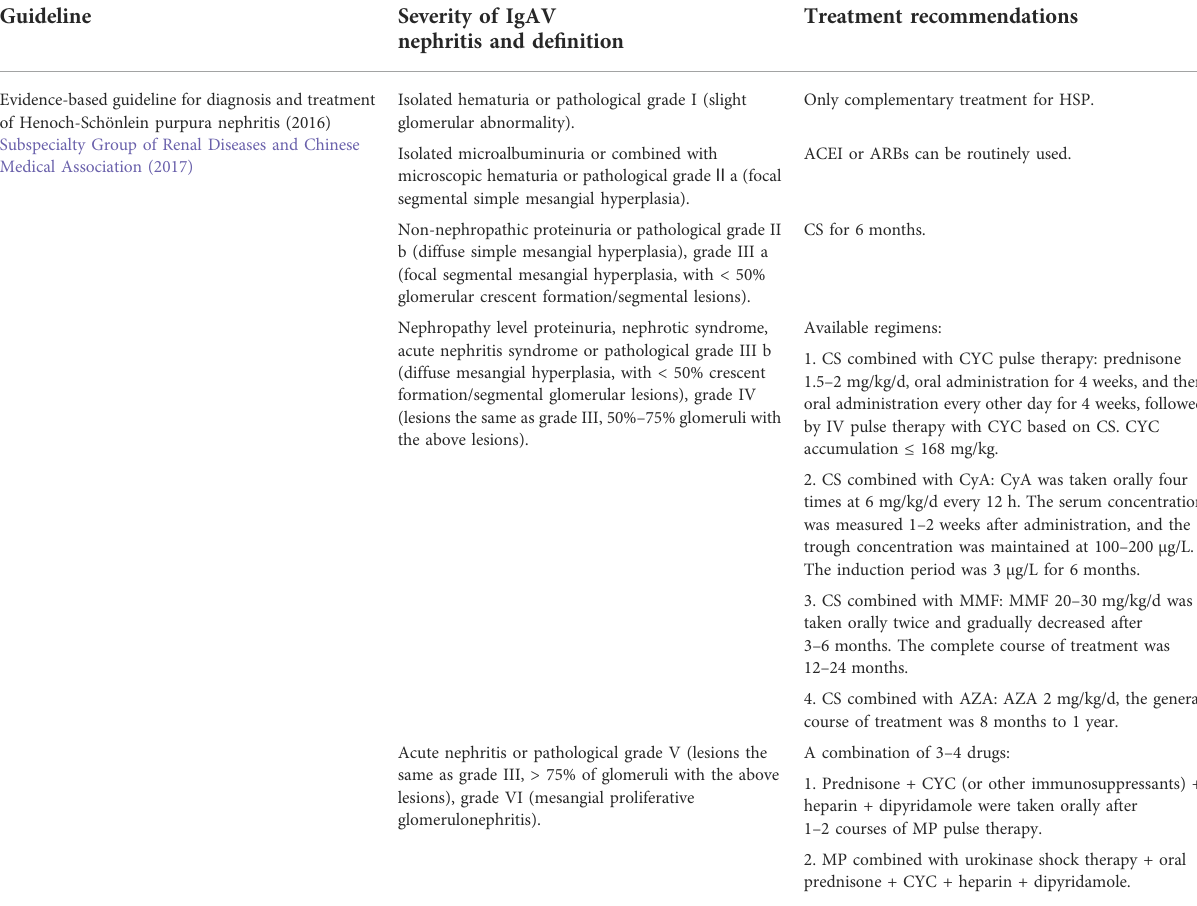
TABLE 1 Comparison of guidelines.